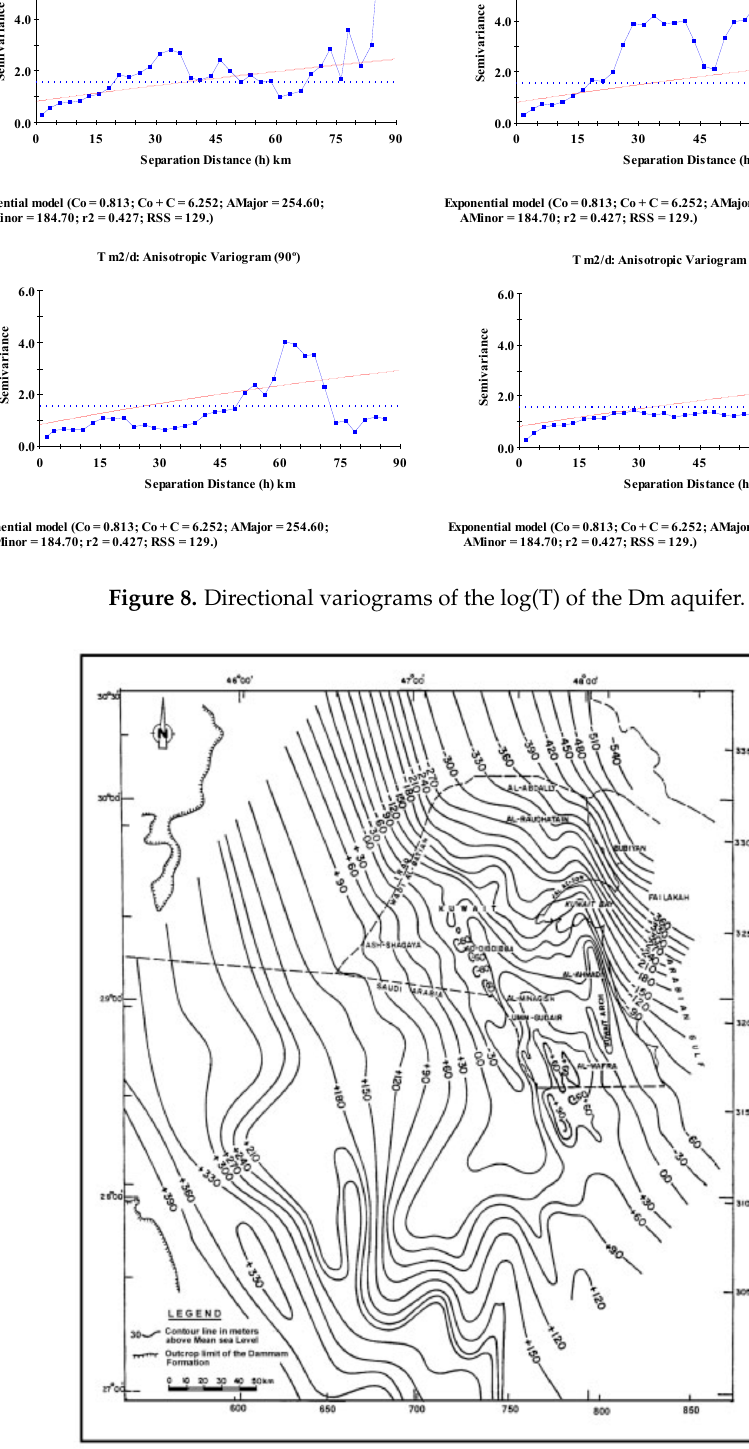
Figure 9. Structural contour map of the top Dammam Formation in and around Kuwait (Source [33] ).